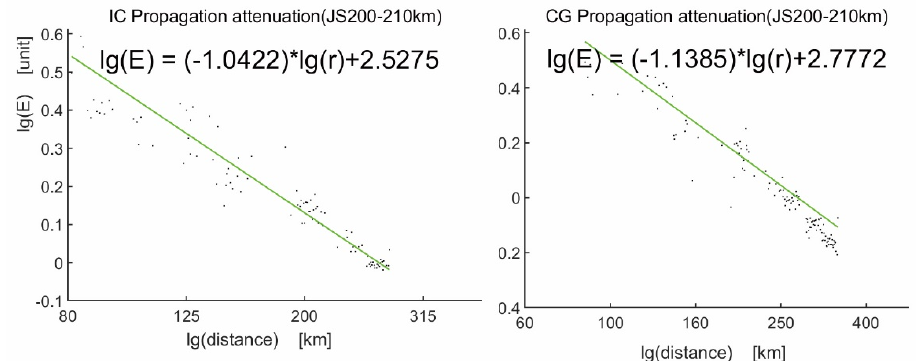
Figure 9. Logarithmic values of peak electric field value at the HF station vs. logarithmic values of distance for lightning events located at 205 km from the JS station.